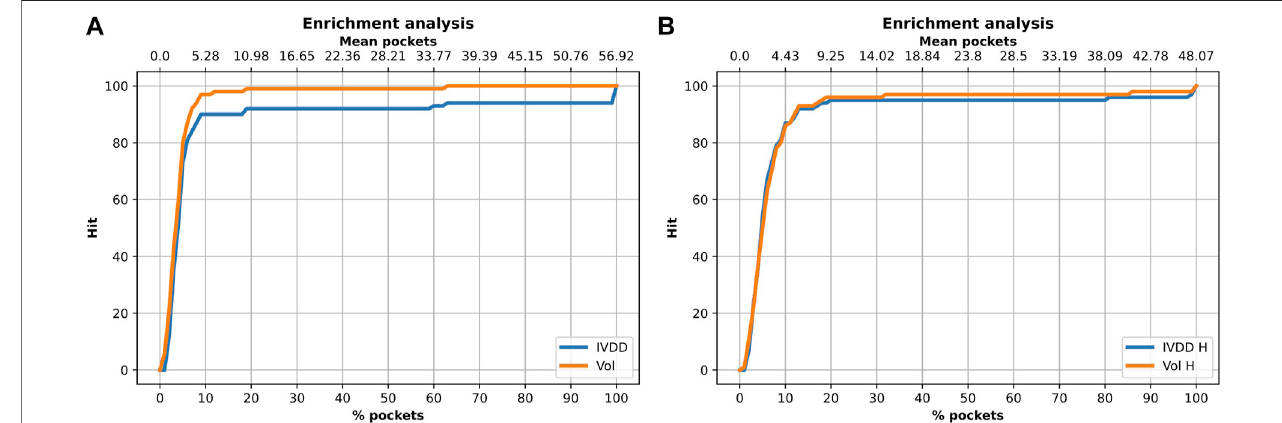
FIGURE 9 | Enrichment analysis on the 100-protein experiment. (A) Solution without hydrogen atoms. For the 10% of pockets (for each protein) with the highest probability(onaverage5.28pockets),theorthostericsiteisfoundin90%ofcaseswithIVDDandin97%ofcaseswiththedescendingrankingofthepocketvolumes. (B)